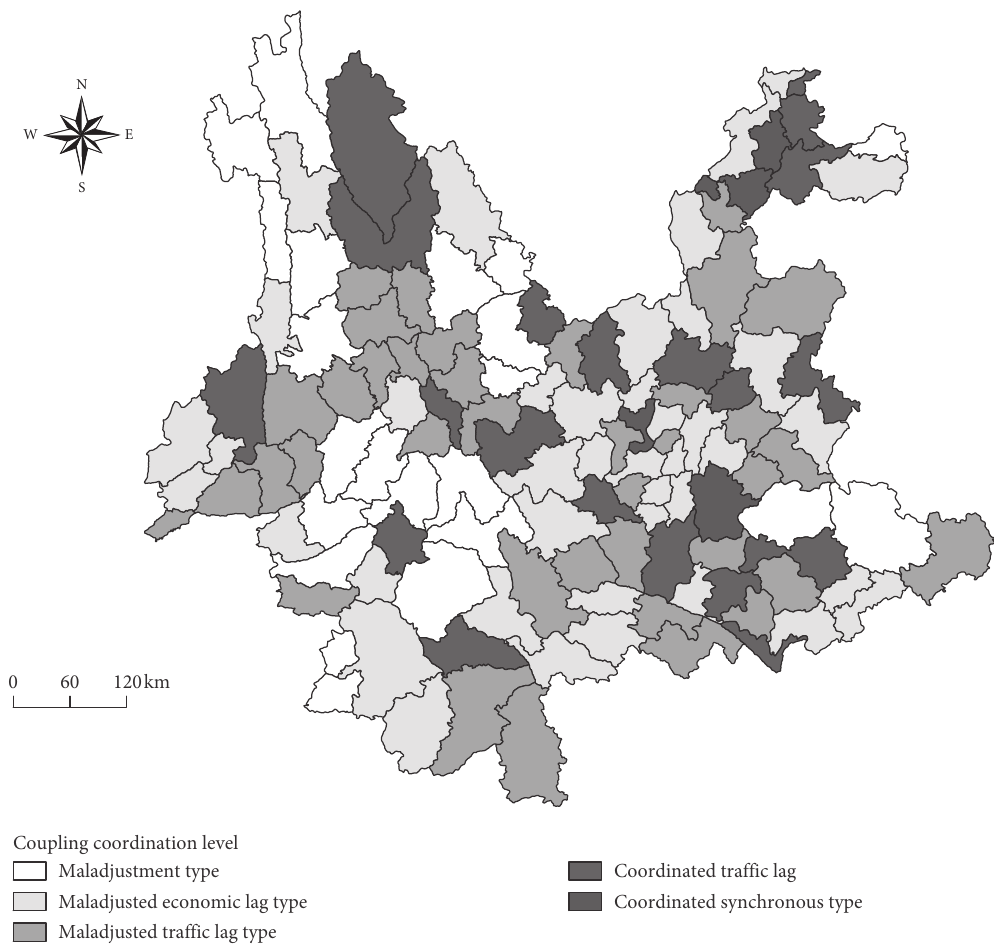
Figure 5: Spatial pattern of coupling coordination